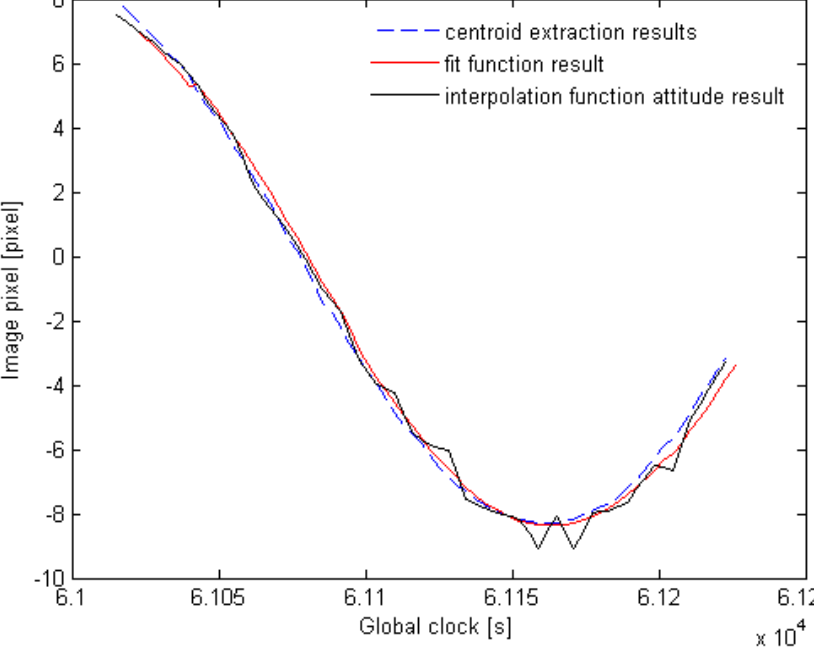
Figure 14. Image pixel offset estimation results for different fitting algorithms.